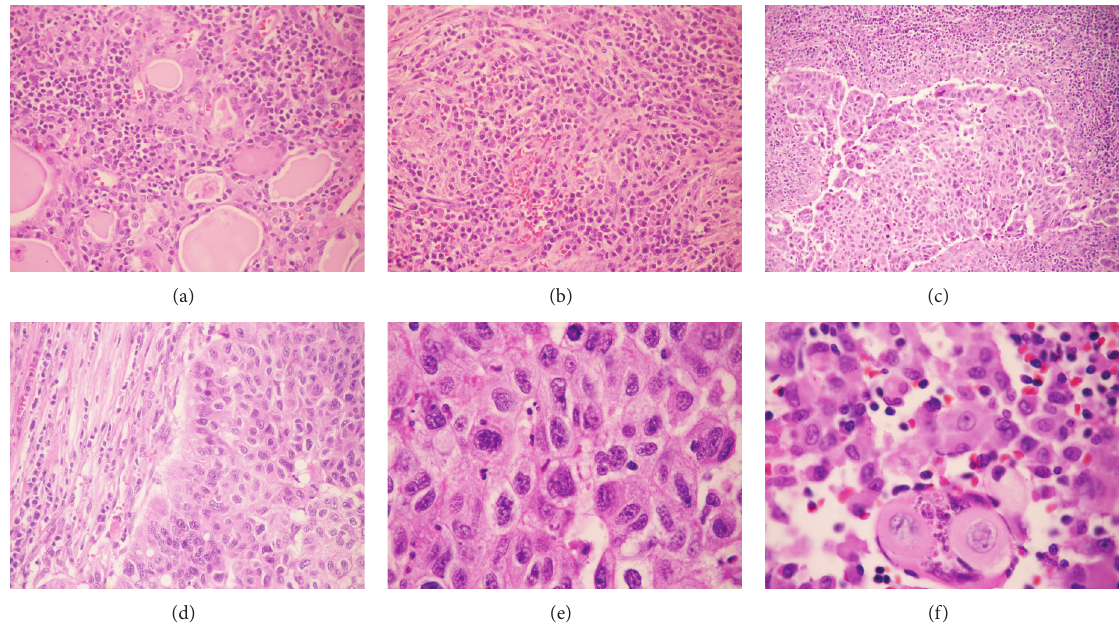
Figure 1: (a) Thyroid adjacent to the tumor with morphological appearance of Hashimoto’s thyroiditis; follicles are surrounded by lymphoplasmacytic inflammatory infiltrate (40x, hematoxylin and eosin (HE)). (b) Fibrotic bands and inflammatory infiltrate (40x, HE). (c) Moderately differentiated squamous cell carcinoma (grade II) infiltrating the stroma of the thyroid (20x, HE). (d) Interface between squamous cell carcinoma and inflammatory stroma (40x, HE). ((e) and (f)) Squamous cell carcinoma showing cellular pleomorphism, bizarre nuclei, and keratinization of individual cells (1000x, HE).